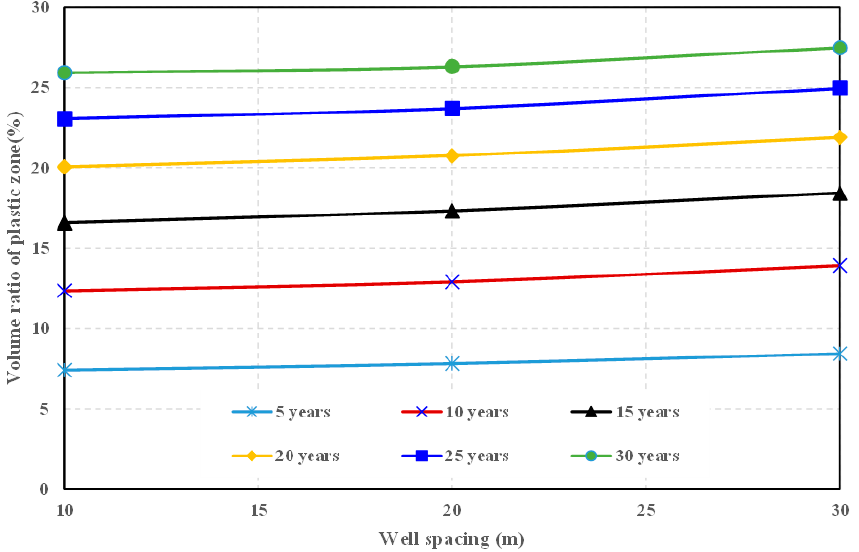
Figure 20. Ratio of plastic zone volume to initial cavern volume with different well spacings after operating for 30 years. operating for 30